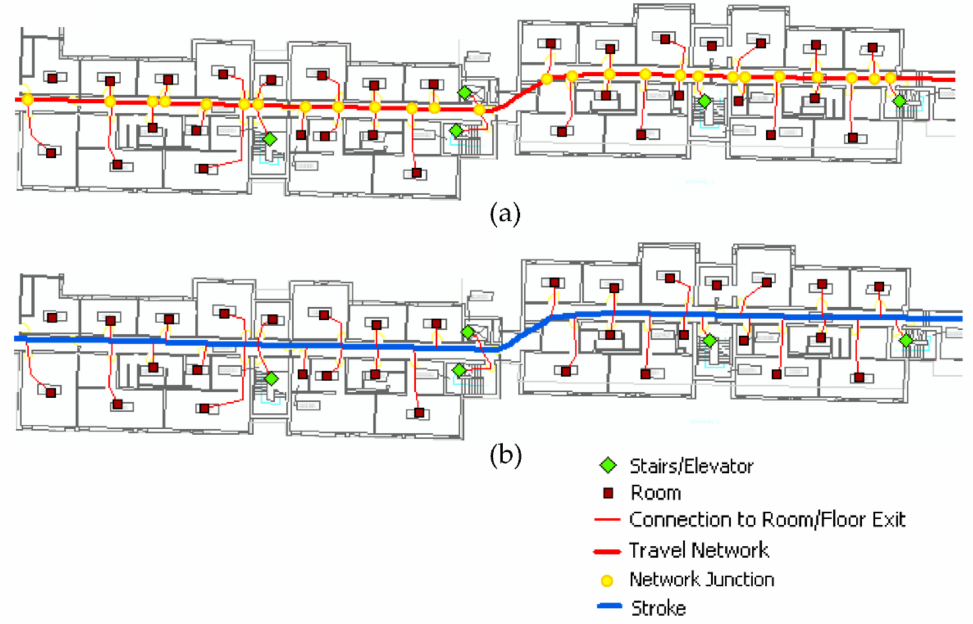
Figure 2. A long corridor represented as a composition of arcs ( a ) and as a stroke ( b